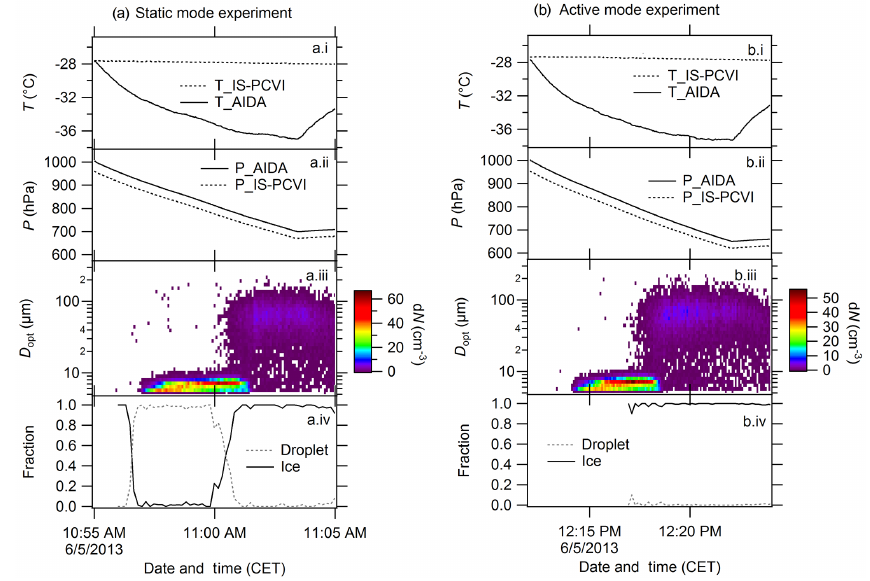
Figure 12. Temporal profiles of the static IS-PCVI/PPD-2K coupling experiment (INUIT05_55) (a) and the active IS-PCVI/PPD-2K cou- pling one (INUIT05_56) (b) . While the IS-PCVI behaves as a regular outlet without any flows in the static mode experiment (a) , all flows and MFCs are activated during the active mode experiment (b) . Panels are coordinate to display T (i), P (ii), the welas OPC size distribution of droplets and ice crystals in optical diameter ( D opt ) during individual expansions (iii), and the PPD-2K-detected droplets and ice particles fraction (iv). The color scale in panels iii represents the binned-number concentration of particles (d N) .